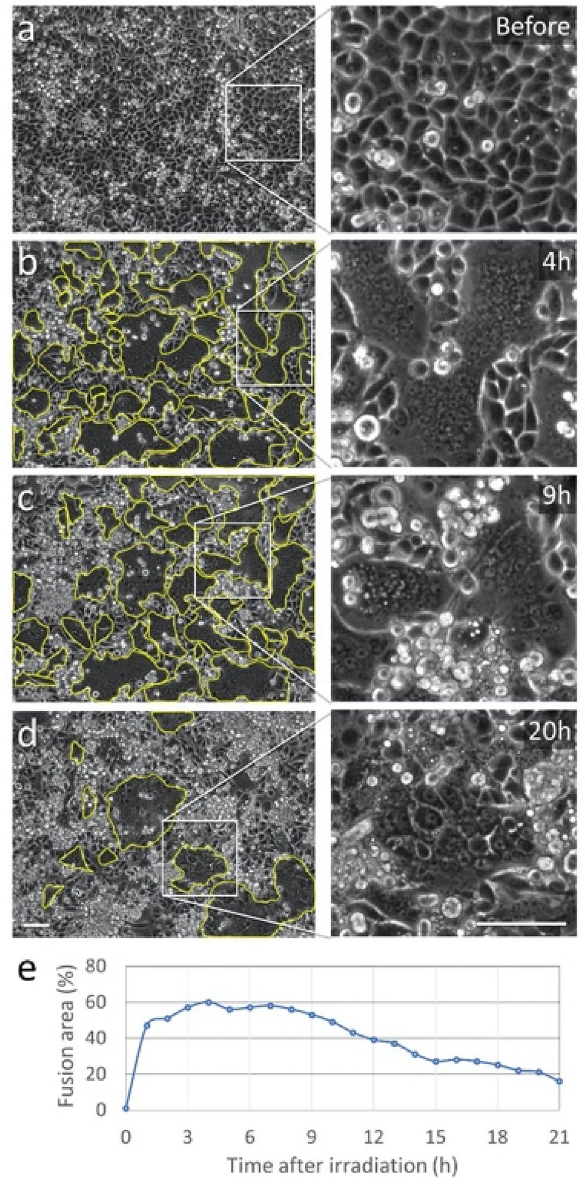
Figure 1. Widespread plasmonic fusion in MDA-MB-468 cancer cells. ( a ) Phase-contrast image of the cell culture before irradiation. Cell membrane is visible as rounded bright curves in the 4× magnified region (right panel), showing a fully confluent culture with an average cell diameter of approximately 10 µm. Dead cells or cells detached from the glass substrate are visible as brighter and smaller circles. ( b ) 4 h after irradiation the relative fusion area (marked by yellow curves) have reached a maximum of 60%. ( c ) The culture has remained stable for up to 9 h after irradiation. ( d ) 20 h after irradiation, most of the multinucleated cells underwent necrosis, where only a few survived, covering approximately 21% of the field of view. Scale bars represent 50 µm. ( e ) Total culture area covered by fused cells for different times after